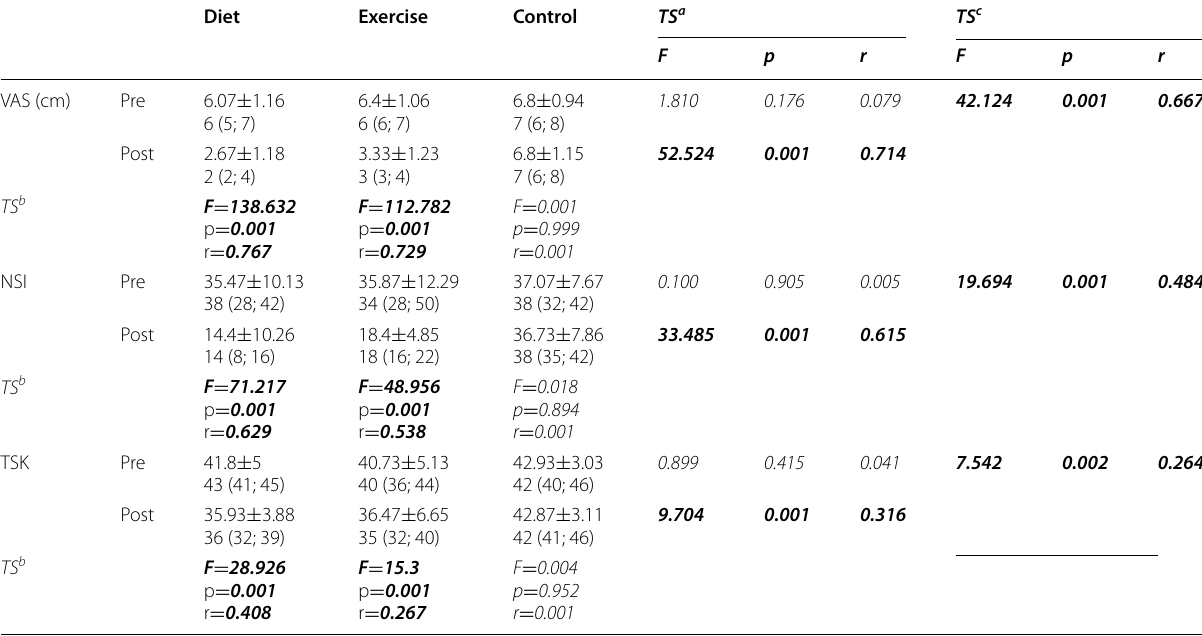
TS test statistics, pre first measurement, post last measurement, F two-way analysis of variance in repeated measures, r effect size. a Comparison between groups, b intra-group comparison, c comparison of pre and post values between groups, summary statistics mean quartile)